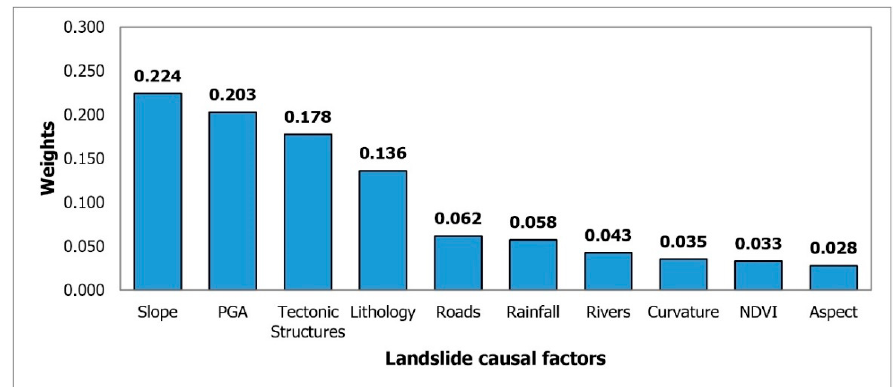
Figure 9. Ranking of weights for the 10 landslide causative factors.